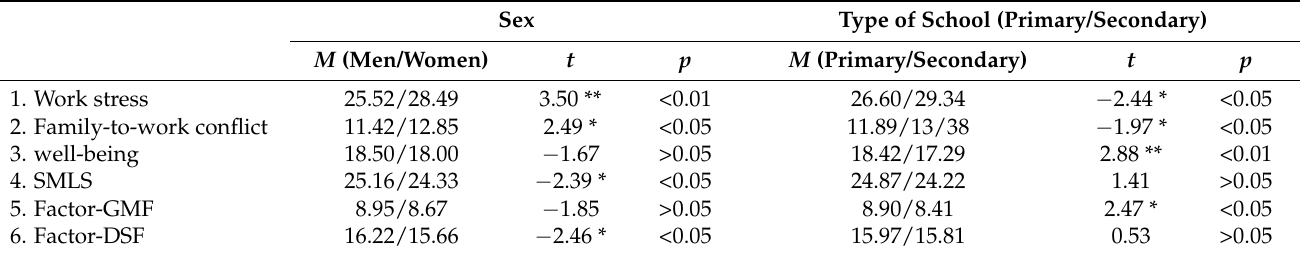
Table 2. Difference analysis of gender and type of